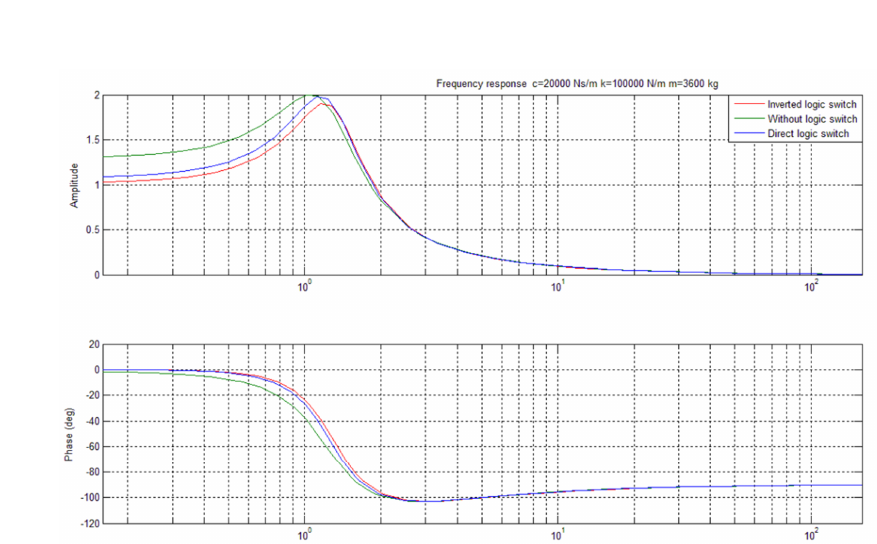
Figure 8 – Transfer function of vertical displacement with the logic switch controller Slika 9 – Penosna funkcija vertikalnog pomeranja s kontrolom logi č kog prekida č a Рис . 9 – Передаточная функция вертикального смещения , управляемая